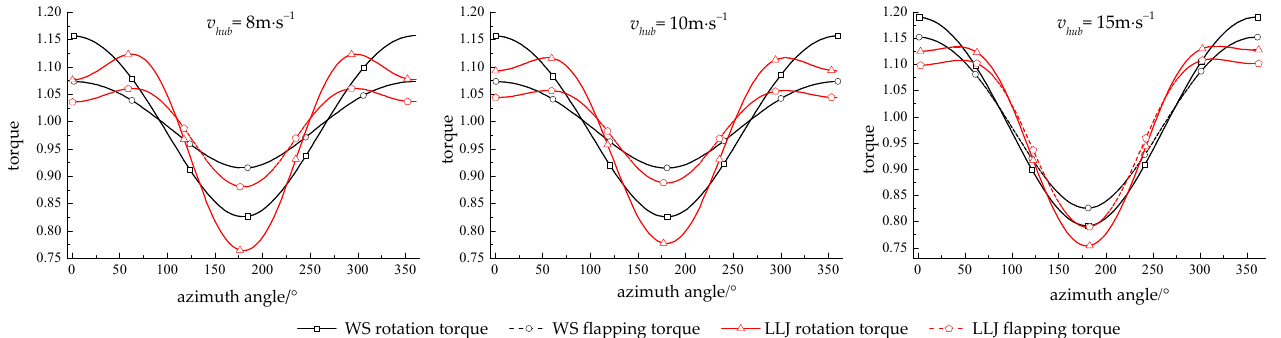
Figure 11. Variation of the blade torque as a function of the azimuth under different working conditions.